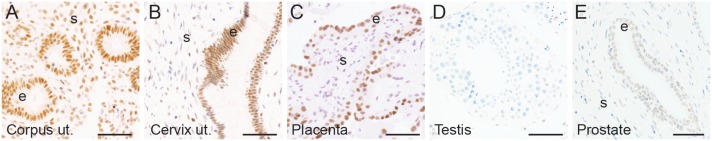
Expression of ZBED1 in reproductive tissues.(A) corpus uterus, (B) cervix uterus, (C) placenta, (D) testis, and (E) prostate. E = epithelial cells, s = stroma cells. Scale bars = 50 μM.